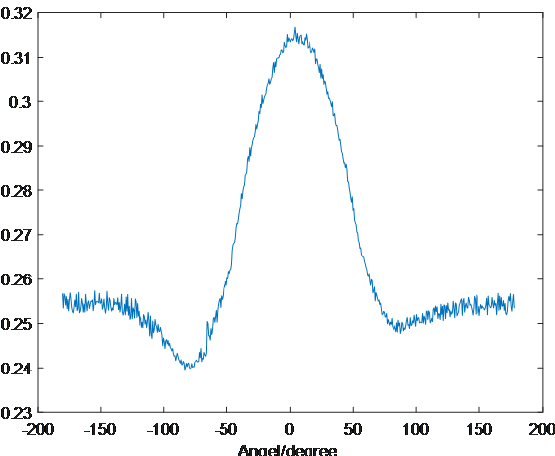
Figure 5. The antenna pattern of UAV − GPR system. The antenna has a good directivity, and the main lobe lies in near the position of 0